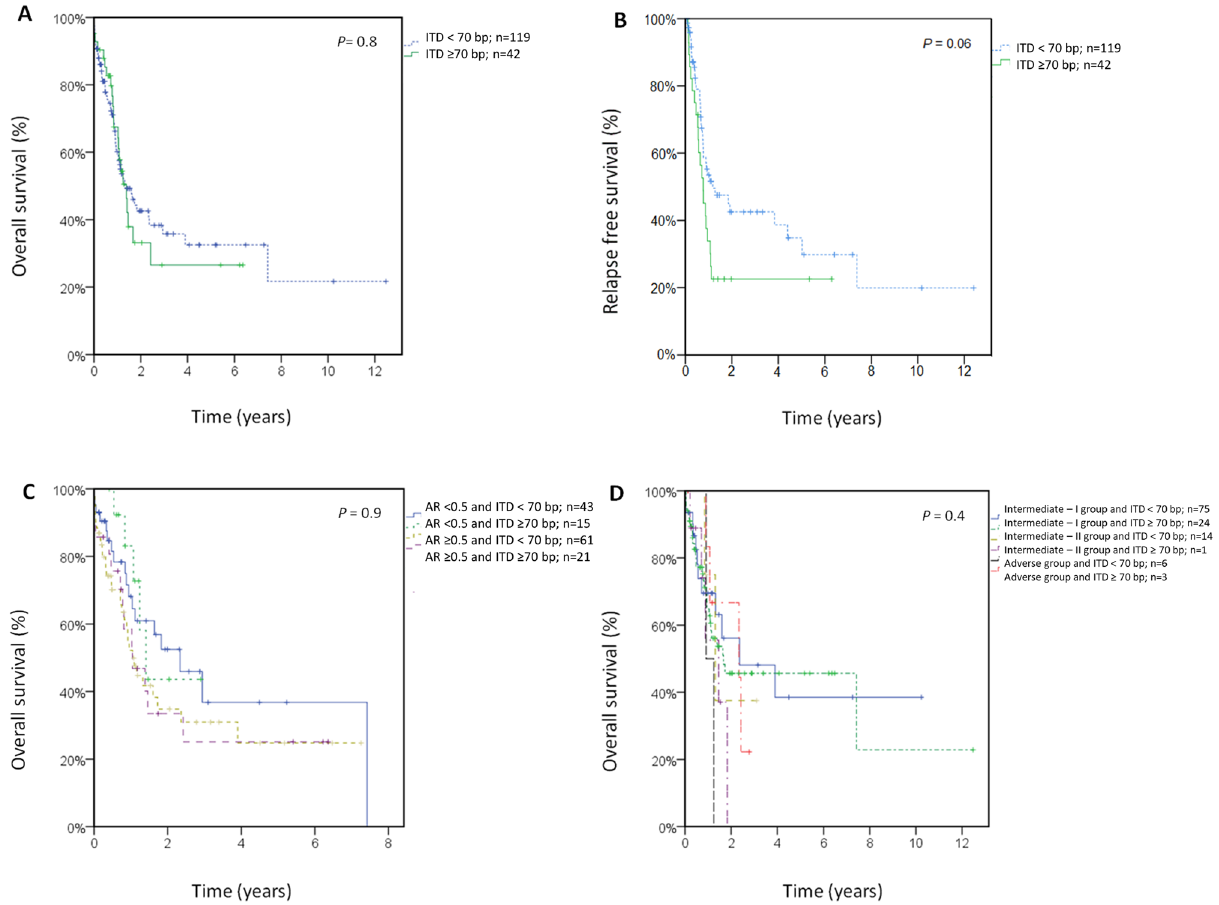
Figure 2. Clinical outcome stratified according to the FLT3 -ITD length (cutoff 70 bp) for all patients treated with intensive chemotherapy. ( A ) Overall survival. ( B ) Relapse-free survival. ( C ) OS according to the FLT3 -ITD length and allelic ratio. ( D ) OS according to the FLT3 -ITD length and 2010 ELN genetic risk. AR, allelic